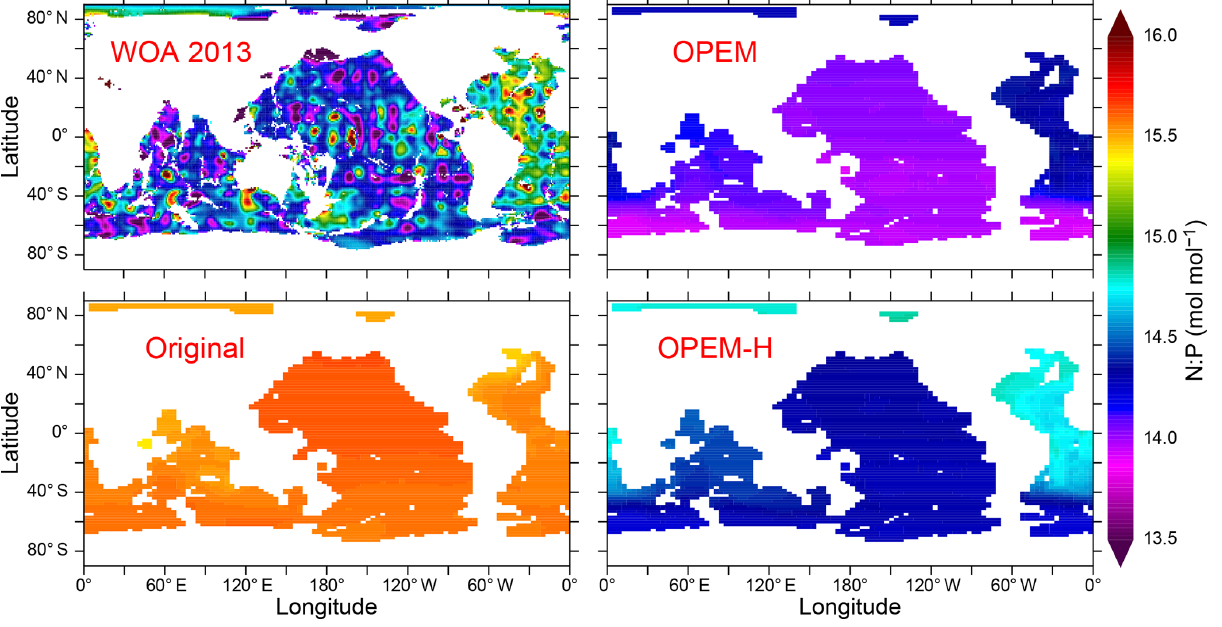
Figure 8. Distribution of DIN : DIP in the deep ocean (at 3200m) in the WOA 2013 climatology and in the original, OPEM, and OPEM-H UVic